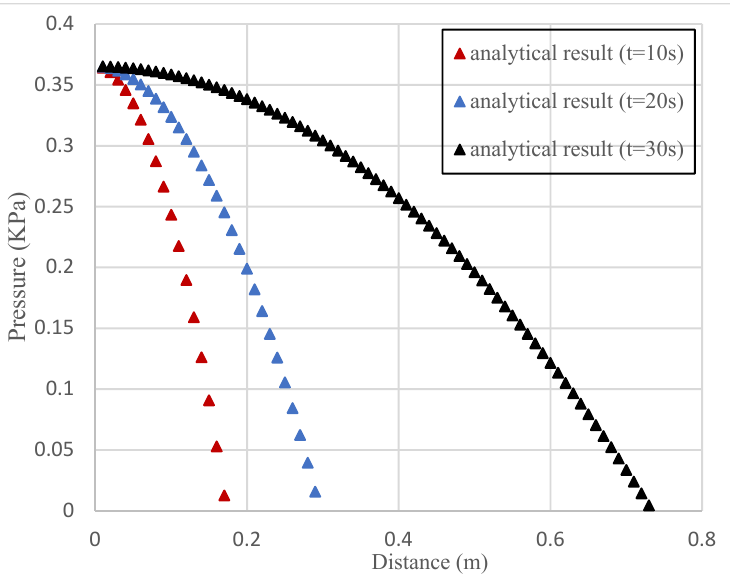
Figure 8. Variation curve of pressure with diffusion distance at different times.